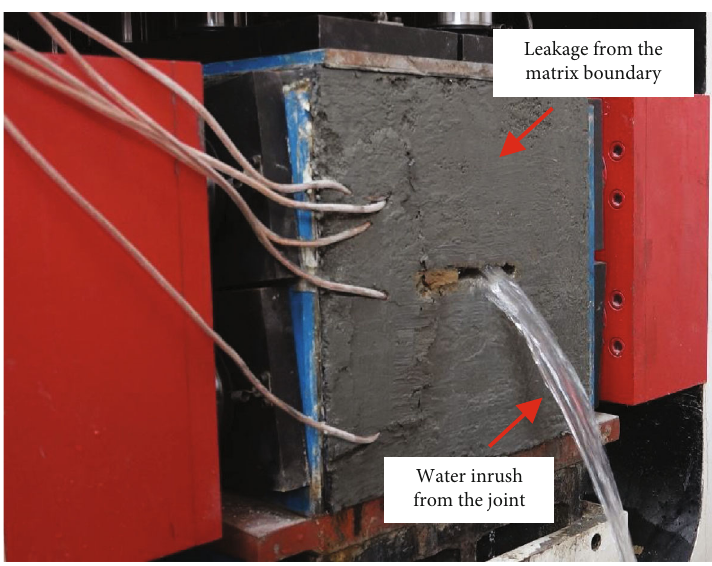
Figure 8: Water seepage characteristics at the model